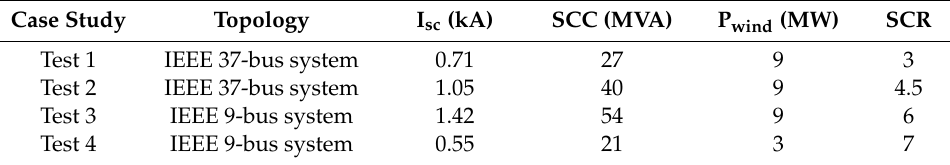
Table 1. Point of Common Coupling (PCC) characteristics of each test